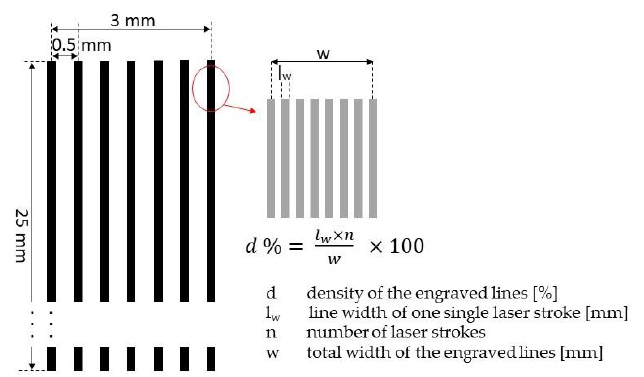
Figure 1. Overview of laser engraving area and lines for Al samples including the corresponding parameters regarding the density of engraved lines.